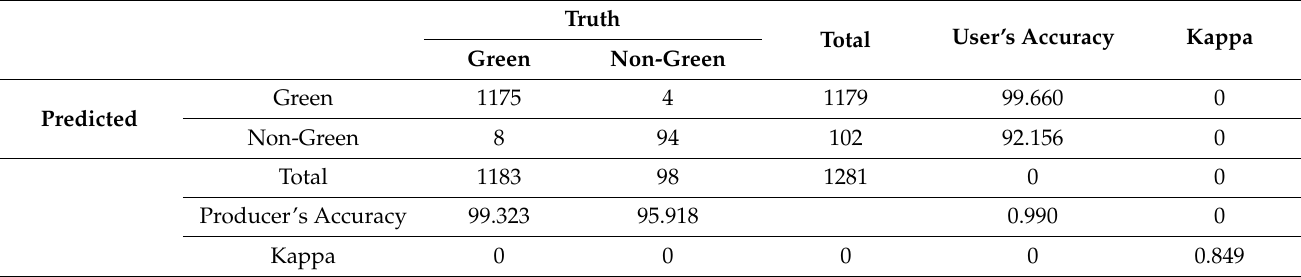
Table 5. Confusion matrix and accuracy assessment of green-non green classification based on ESA CCI 2019.